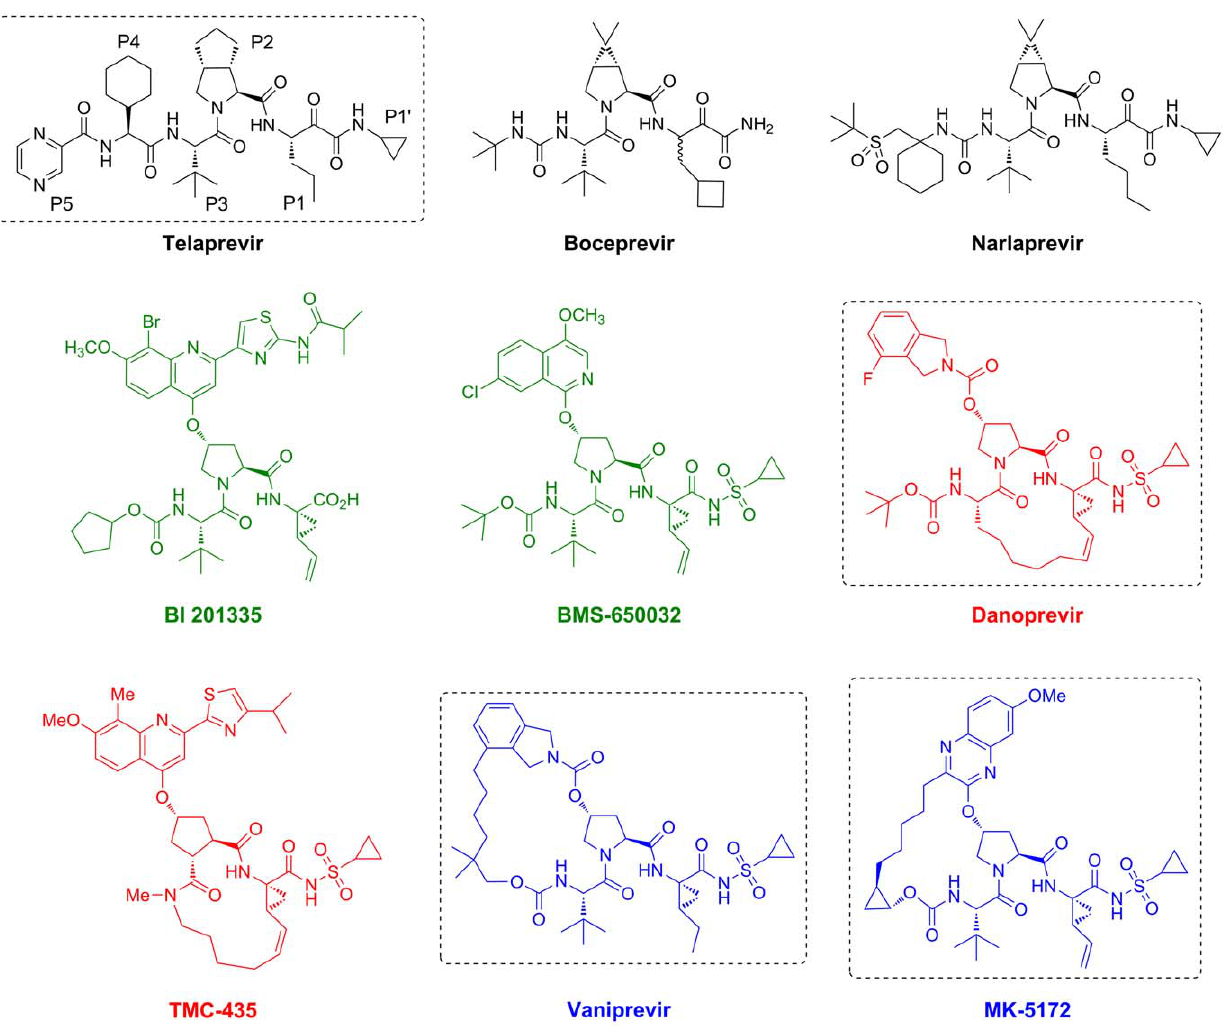
Figure 1. The chemical structures of NS3/4A protease inhibitors. The canonical nomenclature for drug moiety positioning is indicated using telaprevir. Telaprevir (black), danoprevir (red), vaniprevir and MK-5172 (blue) are representative of many other protease inhibitors in development. Telaprevir, recently approved for clinical use, is an acyclic ketoamide inhibitor that forms a reversible, covalent bond with the protease. Danoprevir, currently in phase II clinical trials, is a non-covalent acylsulfonamide inhibitor with a P1–P3 macrocycle. Vaniprevir and MK-5172 are also non-covalent acylsulfonamide inhibitors, but contain P2–P4 macrocycles. Vaniprevir and MK-5172 differ in the construction of their P2 moieties: vaniprevir contains a carbamate linkage between the P2 proline and the isoindoline moiety, whereas MK-5172 contains a shorter ether linkage between its P2 proline and the quinoxaline moiety.